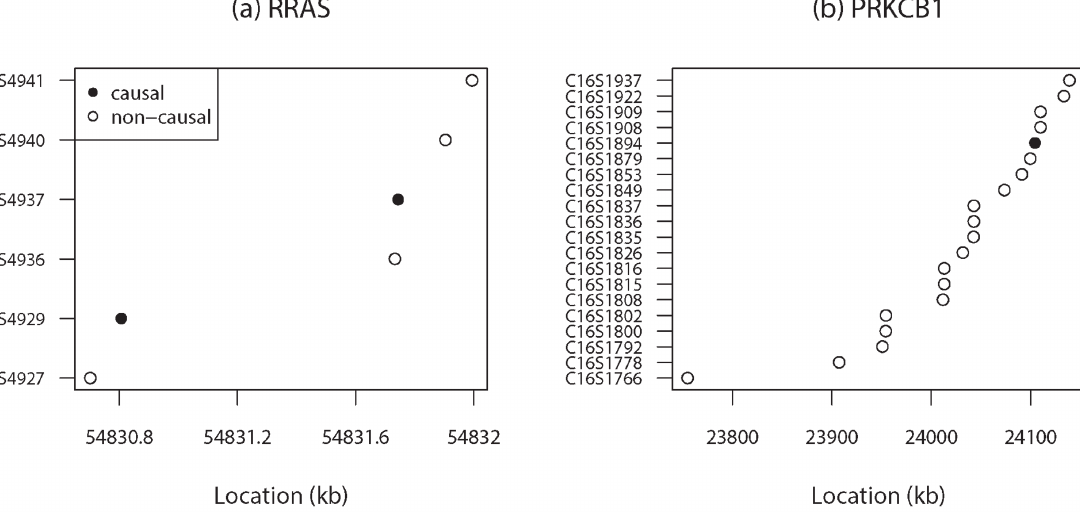
Figure 3. SNV base-pair locations for two-causal genes: (a) RRAS: the average distance between two successive SNVs is 0 : 3 kb with a maximum distance of 0 : 9 kb; (b) PRKCB1: the average distance between two SNVs is 20 kb with a maximum distance of 152 kb.